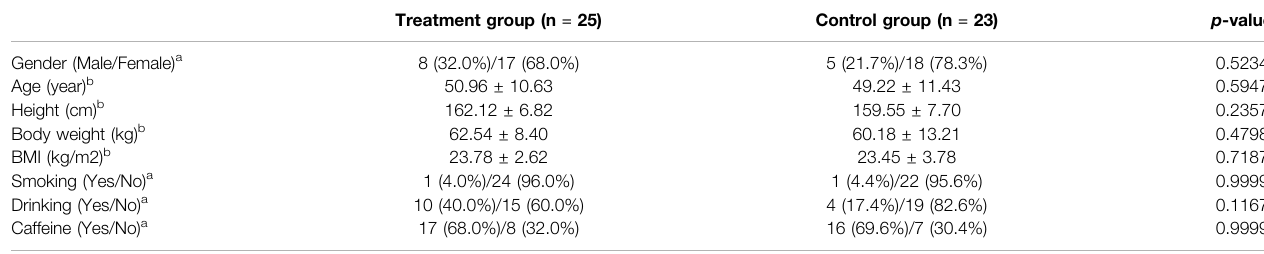
TABLE 1 | Participants baseline characteristics.